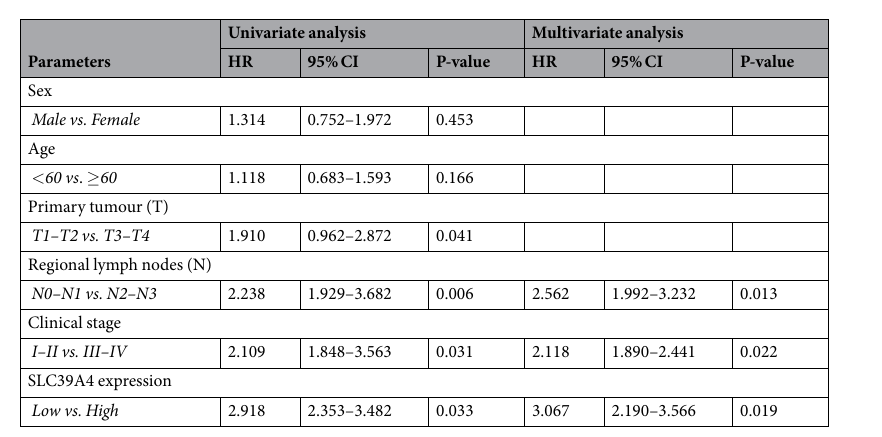
Table 2. Summary of univariate and multivariate analysis of overall survival in